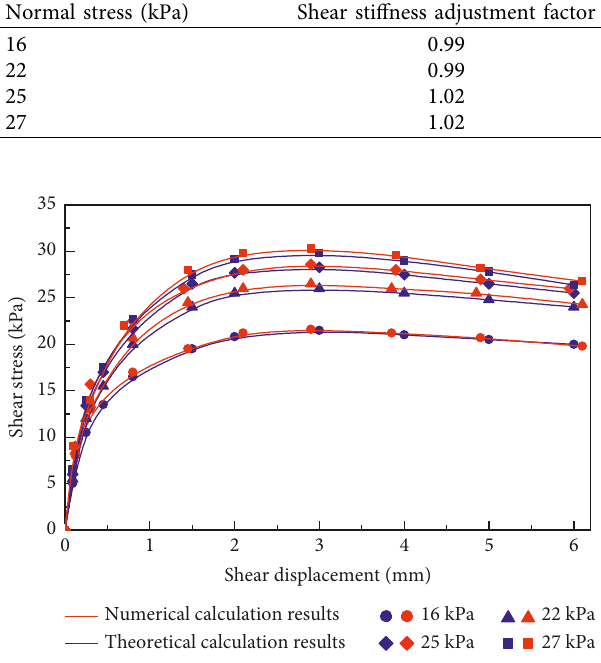
Figure 10: Comparison of the theoretical and numerical calcu- lation results under different normal